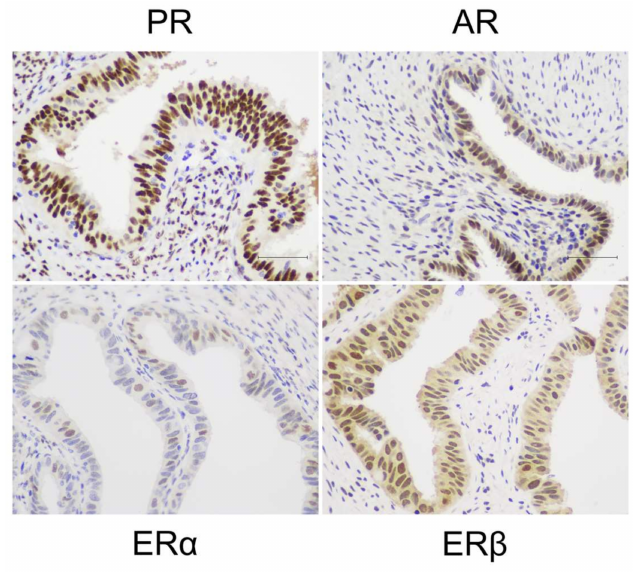
Figure 3. Steroid hormone receptor expression in the FT. Representative micrographs show chromogenic immunostaining of progesterone receptor (PR), androgen receptor (AR), oestrogen receptor α (ER α ) and oestrogen receptor β (ER β ) in the fimbriae of the